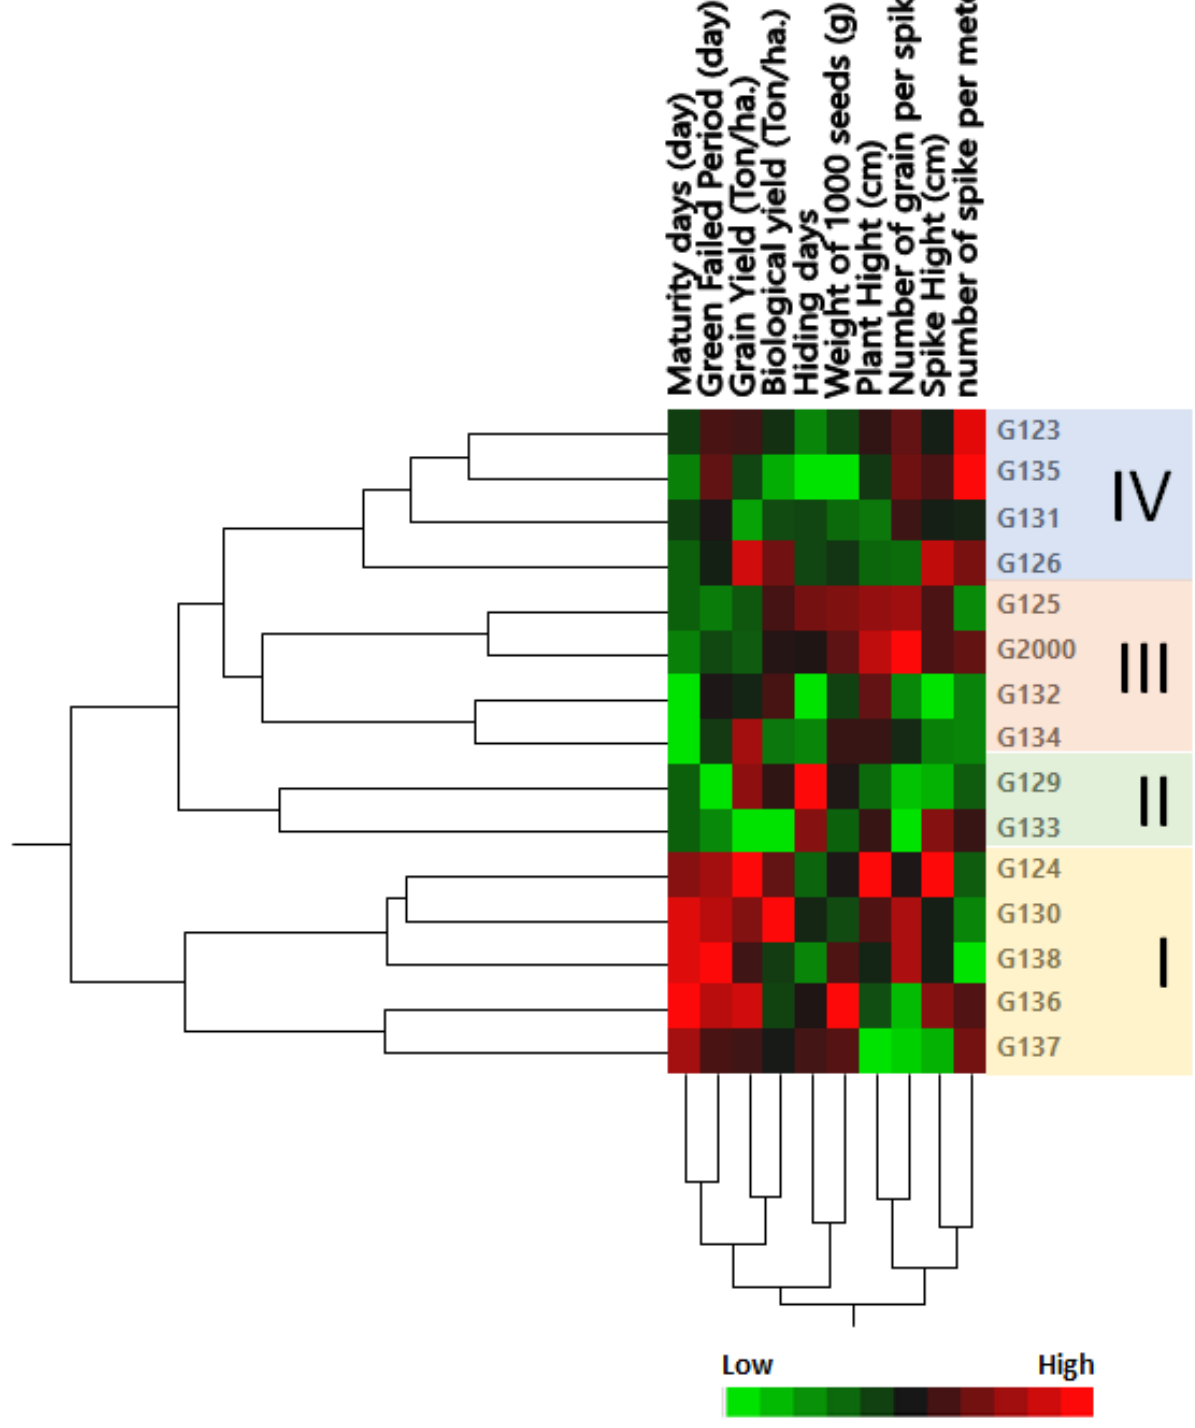
Figure 2. Cluster analysis and heatmap based on agro-morphological traits of 15 Egyptian six-rowed barley cultivars. The heatmap was constructed using JMP ® , Version 15 (SAS Institute Inc., Cary, NC, USA, 1989–2019).